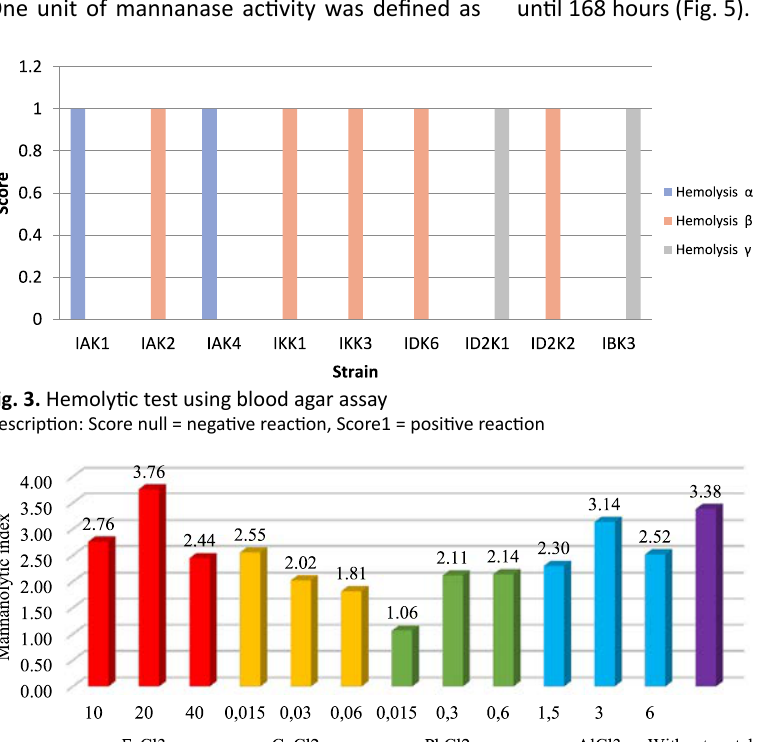
(0.015mM, 0.03mM, 0.06mM), PbCl 2